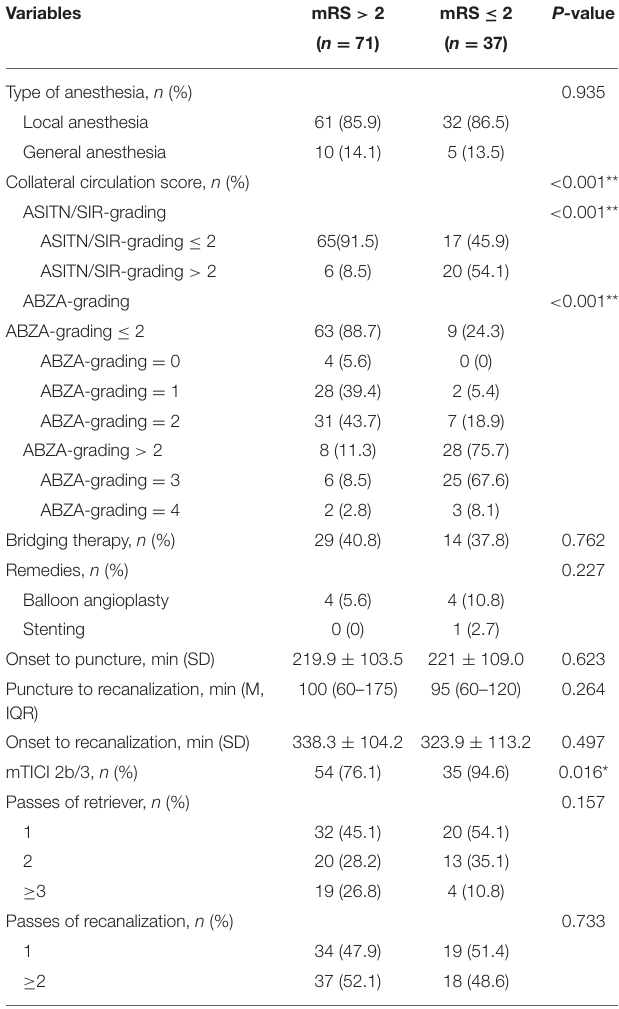
ABZA-grading (poor vs. good), mTICI (poor vs. good) were included in logistic regression analysis by enter method, and two models were established. ROC curve was used to analyze the prediction accuracy of each models. The results are shown in Table 3 . Model 1 and model 2 were manually screened out either ASITN/SIR-grading or ABZA-grading, respectively. The AUC of Model 1 was 0.903 (95% CI: 0.844–0.961; P < 0.001) and Model